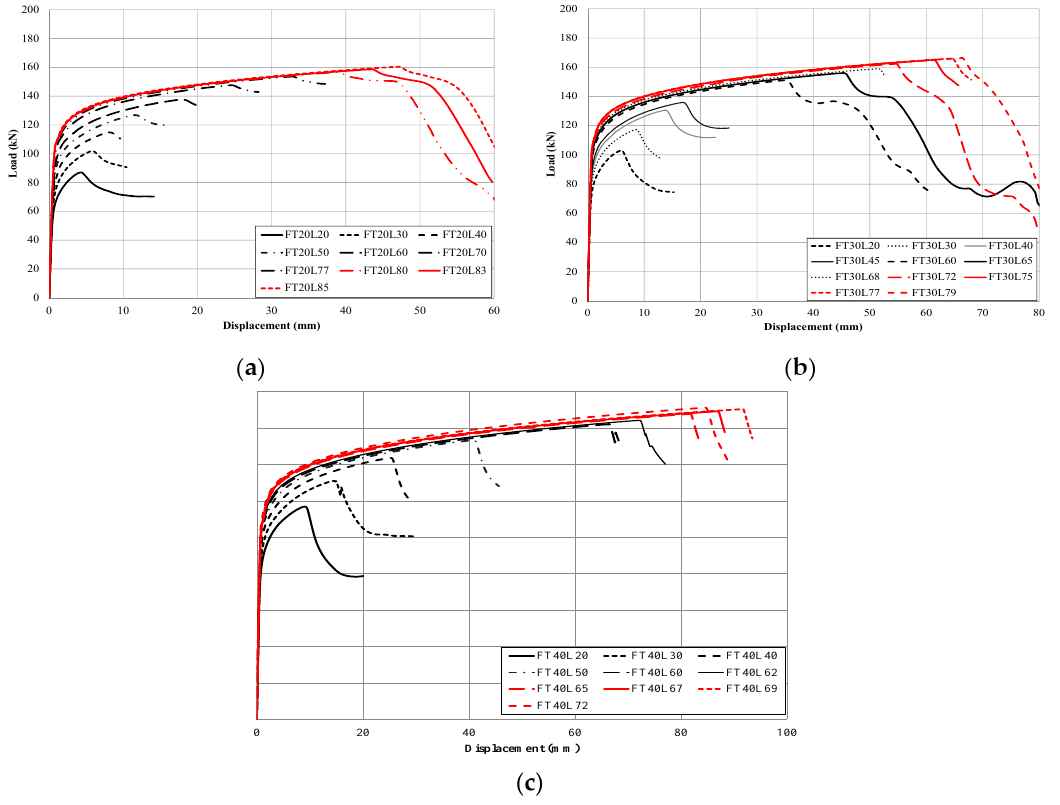
Figure 6. Load-displacement curves of parametric analysis results: ( a ) FT20 series (T = 20 mm), ( b ) FT30 series (T = 30 mm), ( c ) FT40 series (T = 40 mm). Table 3. Parametric analysis results.